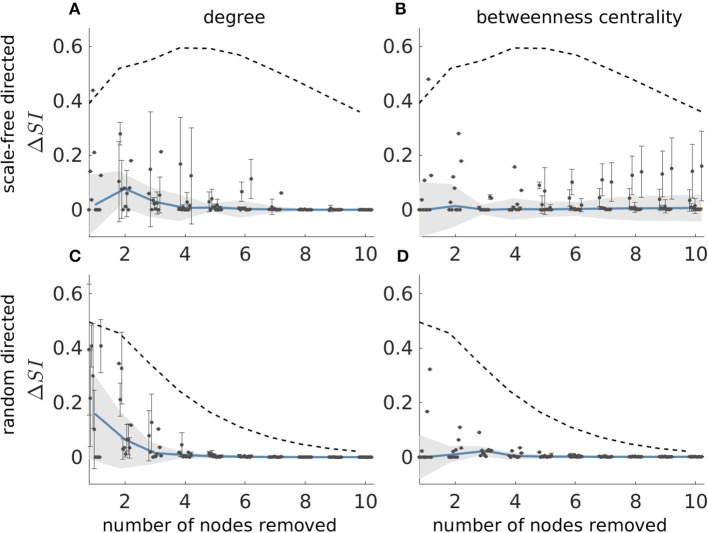
Difference between the SI value of the most ictogenic set as identified from the ground truth and the average SI of the sets which caused a maximal reduction in average degree (A,C), and average betweenness centrality (B,D), i.e., ΔSI, as a function of resection size. Error bars denote the standard deviation of the ΔSI values across the different sets that yield the maximal reduction in average degree or betweenness centrality when removed. The blue curve describes the median of the ΔSI values across 10 network realizations (black dots) and the shaded area their median absolute deviation (the dots are slightly shifted in the x-axis for better visualization). (A,B) Correspond to scale-free directed networks, whilst panels (C,D) to random directed networks. The dashed line denotes the average ΔSI between the SI of the ground truth most ictogenic set and the SI of all other possible sets (also averaged over the 10 network realizations). Parameters are the same as in Figure 2.